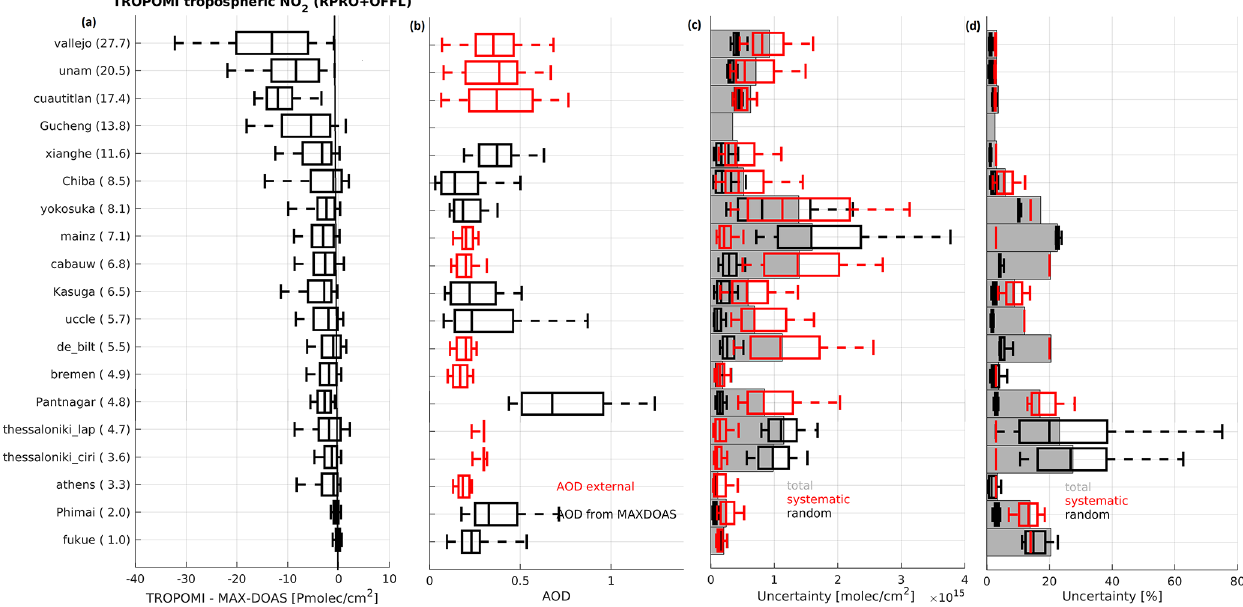
Figure A1. (a) Box-and-whisker plots summarizing the TROPOMI–MAX-DOAS tropospheric VCD difference, per station, ordered as a function of the median ground-based tropospheric column (largest median VCD values on top). Panels (b, c, d) present, respectively, the assumed aerosol optical depth (AOD; either retrieved from the MAX-DOAS measurement or taken from the climatology used in the NO 2 retrieval), the MAX-DOAS absolute uncertainties, and the relative uncertainties (total median uncertainty in grey bars, random part in black and systematic part in